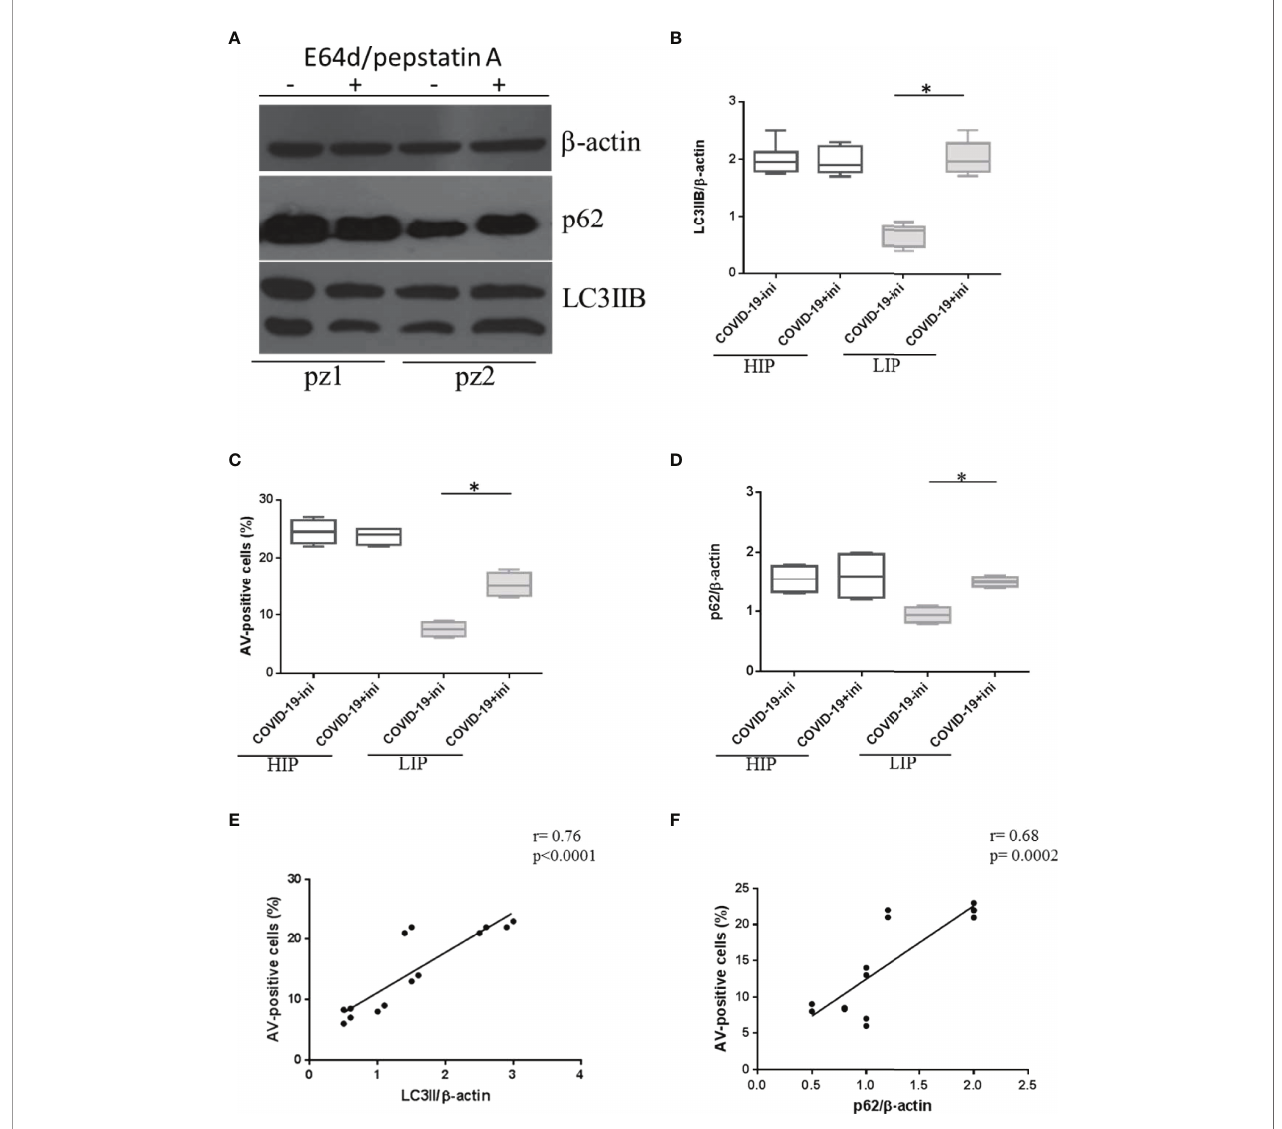
FIGURE 3 | Expression level of autophagy and apoptosis markers in HIP and LIP COVID-19 patients treated with lysosomal inhibitors. (A) LC3IIB and p62 Western blotting analysis of PBMC lysate (30 m g/lane) from 2 representative COVID-19 patients (1 HIP indicated as pz1 and 1 LIP indicated as pz2 of the 18 analyzed). Densitometry analysis of LC3IIB (B) and p62 (D) levels relative to b -actin is also shown (Mann – Whitney test). (C) Flow cytometry analysis of PBMC apoptosis. Data are referred to as AV-positive cells and are presented as independent experiments performed in PBMCs from COVID-19 patients ( n = 18) (Student ’ s t-test). Where indicated, cells were treated with the lysosomal inhibitors E64d and pepstatin A indicated as “ ini. ” Values are expressed as means ± SD. * p < 0.05. (E, F) Correlation and linear regression analysis of apoptosis and LC3IIB and p62 levels in PBMCs from COVID-19 patients. HIP, high in fl ammatory pro fi le; LIP, low in fl ammatory pro fi le; PBMC, peripheral blood mononuclear cell; COVID-19, coronavirus disease 2019; AV, annexin